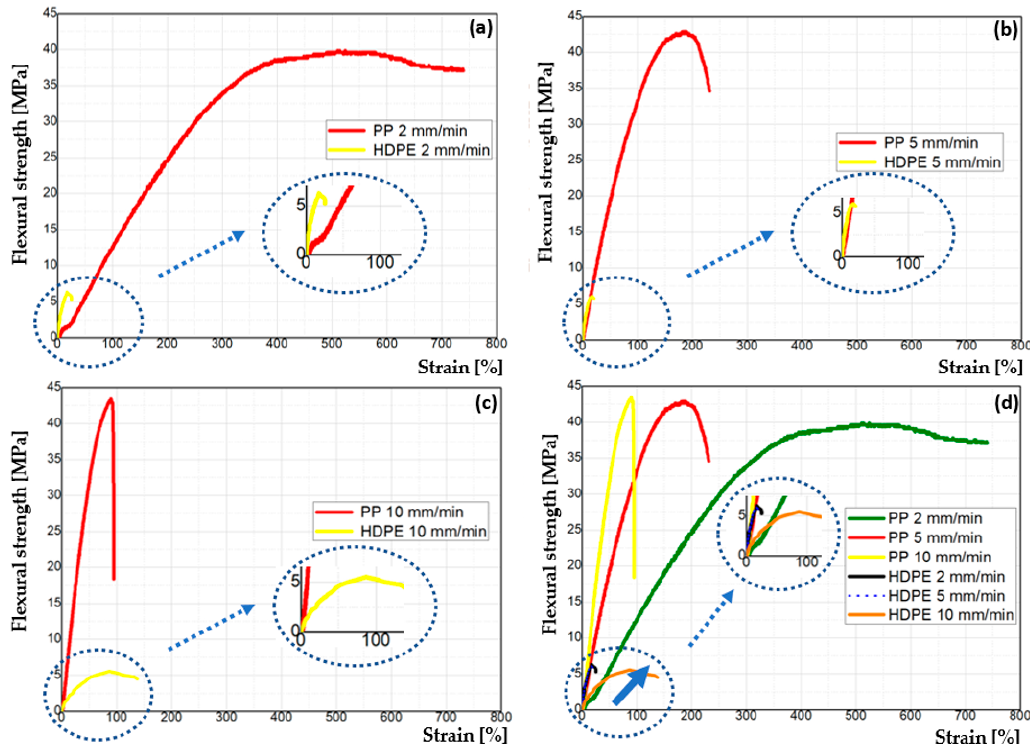
Figure 6. Flexural strength versus deformation (strain) curves: ( a ) PP and HDPE at the strain rate of 2 mm · min − 1 ; ( b ) PP and HDPE at the strain rate of 5 mm · min − 1 ( c ) PP and HDPE at the strain rate of 10 mm · min − 1 and ( d ) PP and HDPE at the several strain rate (from 2 mm · min − 1 to 10 mm · min − 1 ). It was observed that PP2 samples showed highest flexural strength of blocks tested.